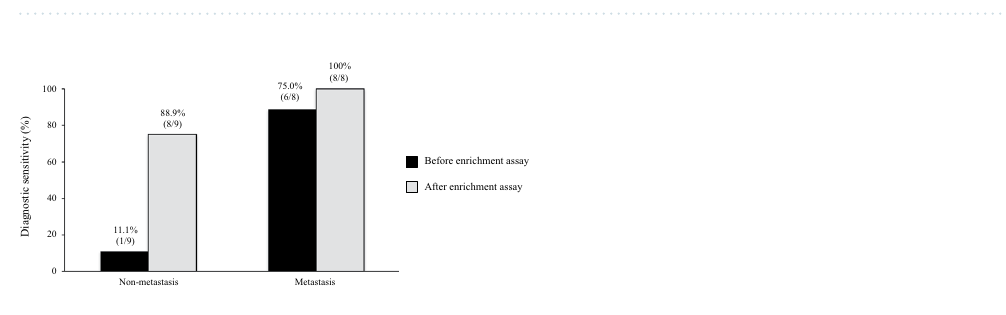
Figure 2. Diagnostic sensitivities, in terms of pathological